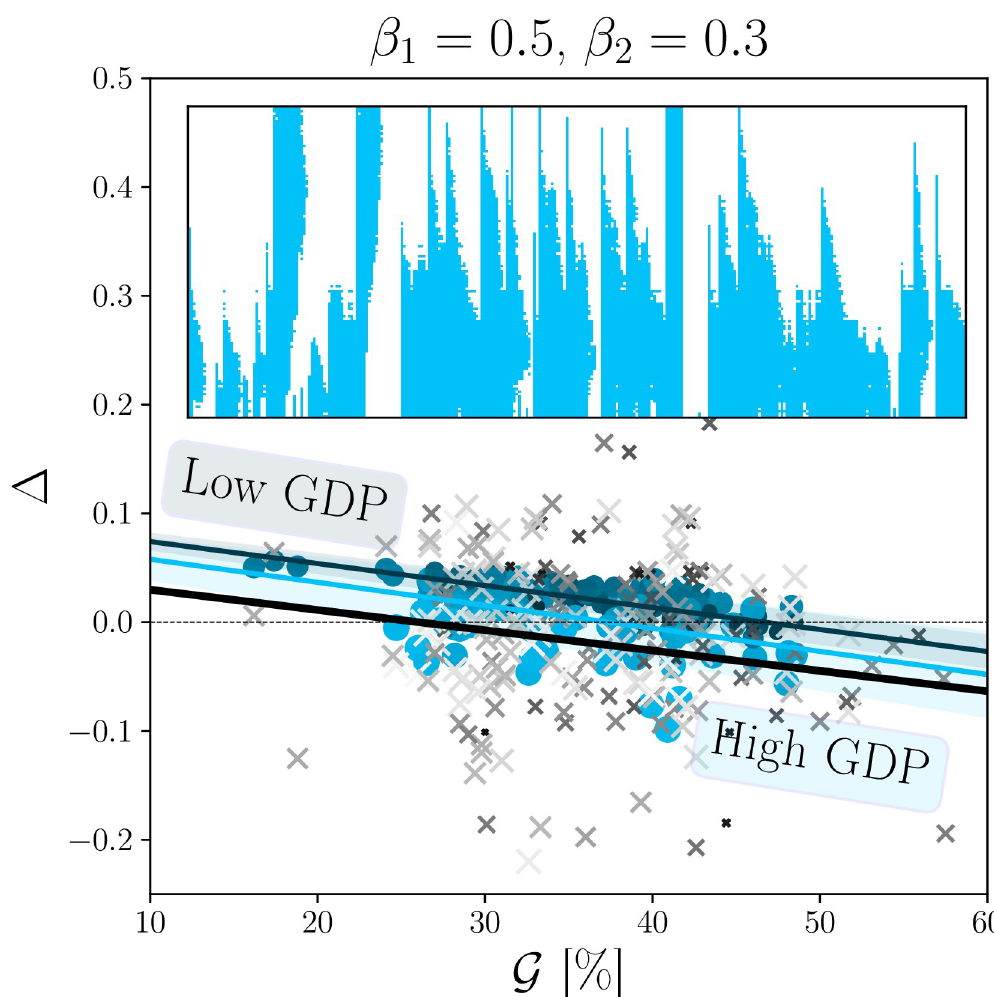
Fig 5. The panel shows the numerical simulation corresponding to the parameters that best fit real data, i.e. β 1 = 0.5, β 2 = 0.3, λ = 0.01. The brightness and the size of each point is proportional to the GDP per capita: the bigger (or brighter) the dot is the stronger is the economy it represents. In each panel the markers (‘x’) correspond to real data and are shown in shades of grey. The solid black line is the linear regression through real data, which is found to be very similar for rich countries and for poor countries. The horizontal dashed black line shows the reference line Δ = 0. The two coloured lines represent the linear regressions (errors on the regressions are also displayed as coloured bands) for low GDP/cap. countries (dark blue) and high GDP/cap. countries (light blue), again very similar to one another and to real data. The upper panel shows a numerical realisation of the crisis dynamics, as in Fig 2, for the same values of β 1 , β 2 , λ and with G ¼ 0 : 411 and E ½ z � ¼ 10 , corresponding to the US economy in 2016 [35]. In this example, low-income households are more frequently in a low consumption state, although occasional crises also hit high earners (see left part of the time